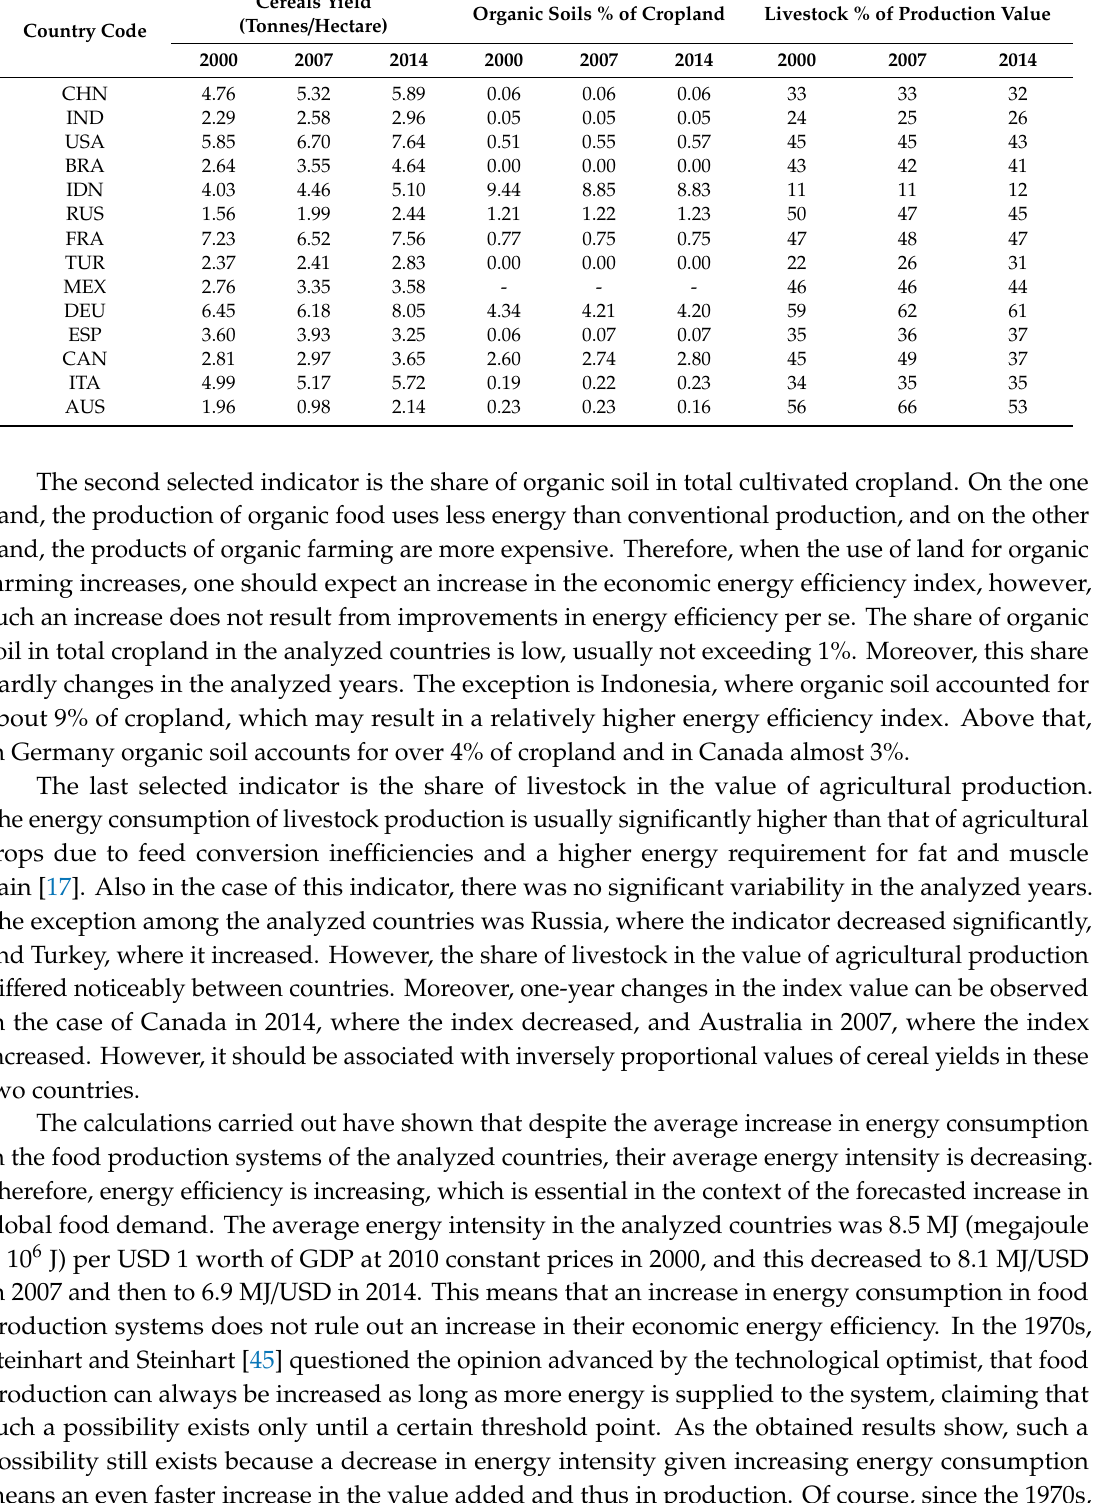
Table 1. Selected production and cultivation indicators in analyzed countries. Cereals Yield Organic Soils % of (Tonnes / Hectare) Country Code